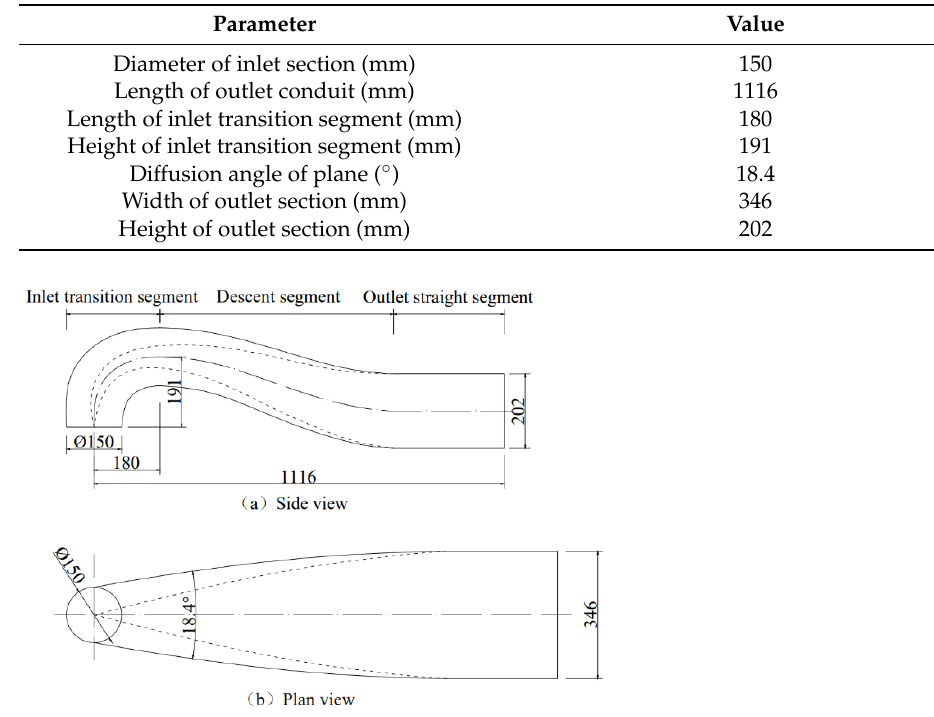
Table 1. Detailed geometrical parameters of model low hump outlet conduit.